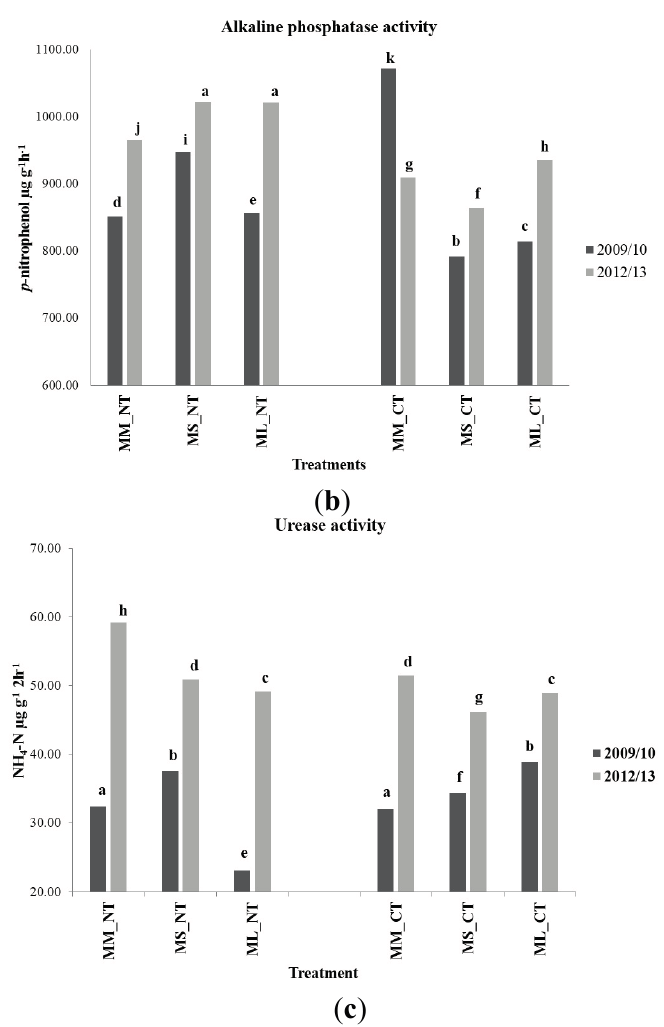
Figure 8. ( a ) Column chart comparing the effects of cropping systems and degrees of soil disturbance on β -glucosidase activity levels during the 2009/2010 and 2012/2013 planting seasons. ( b ) Column chart comparing the effects of cropping systems and degrees of soil disturbance on alkaline phosphatase activity levels during the 2009/2010 and 2012/2013 planting seasons. ( c ) Column charts comparing the effects of cropping systems and degrees of soil disturbance on urease activity levels during the 2009/2010 and 2012/2013 planting